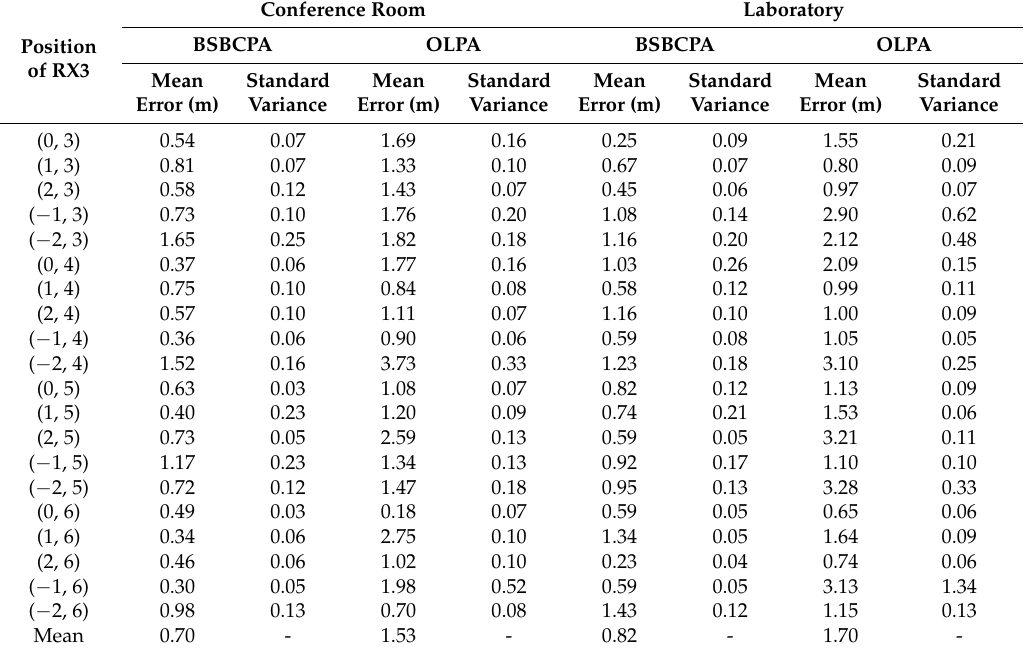
Figure 10. ( a ) CDF of the positioning error in the conference room. ( b ) CDF of the positioning error in the laboratory. Table 3. Statistical results of 2D indoor location estimation.